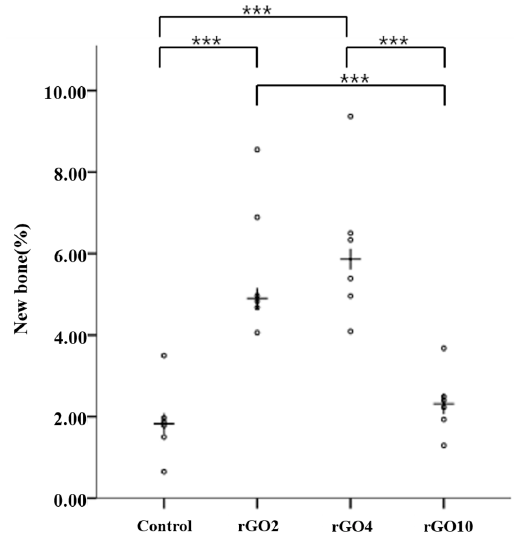
Figure 10. Scatter plot and medians (crosses) of new bone area percentages (%) at 8 weeks after surgery (*** p < 0.001).